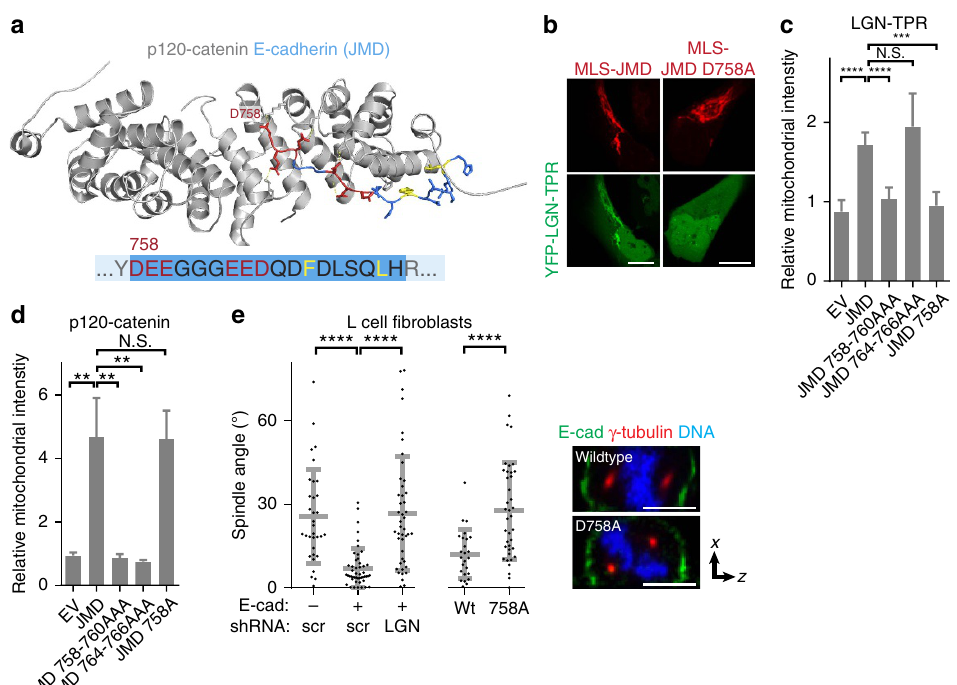
Figure 4 | E-cadherin-induced spindle orientation is dependent on LGN binding. ( a ) Three-dimensional structure of the interaction between p120-catenin and the juxtamembrane domain (JMD) of E-cadherin, indicating the two negatively charged triplets (red) and hydrophobic residues (yellow) within E-cadherin that contribute to p120-catenin binding; based on ref. 33. ( b , c ) Recruitment of YFP–LGN–TPR to wild-type or D758A JMD, which was targeted to mitochondria by fusion with the mitochondrial localization signal (MLS) of ActA. The quantification shows the ratio of mitochondrial versus cytosolic YFP–LGN–TRP on co-expression of empty vector (EV), wild-type JMD or the indicated mutants; n ¼ 5. ( d ) Quantification of the recruitment of GFP-p120- catenin to JMD, containing indicated point mutations, and targeted to mitochondria by fusion with the MLS of ActA; n ¼ 5. ( e ) Quantification of mitotic spindle angle relative to the basal surface of parental L-cells, L-cells-expressing E-cadherin with either scrambled (scr) or LGN shRNAs, or L-cells- expressing wild-type or D758A E-cadherin-GFP, pooled from three independent experiments. Right: xz -projection of mitotic cell showing similar lateral distribution at cell–cell contacts of wild-type and D758A E-cadherin-GFP. Quantified data were pooled from three independent experiments, grey bars in dot plots show mean ± s.d. Scale bars, 5 m m. ** P o 0.003, *** P o 0.0002, **** P o 0.0001, N.S. ¼ not significant using unpaired student t -test ( c , d ) or Mann– Whitney test ( e